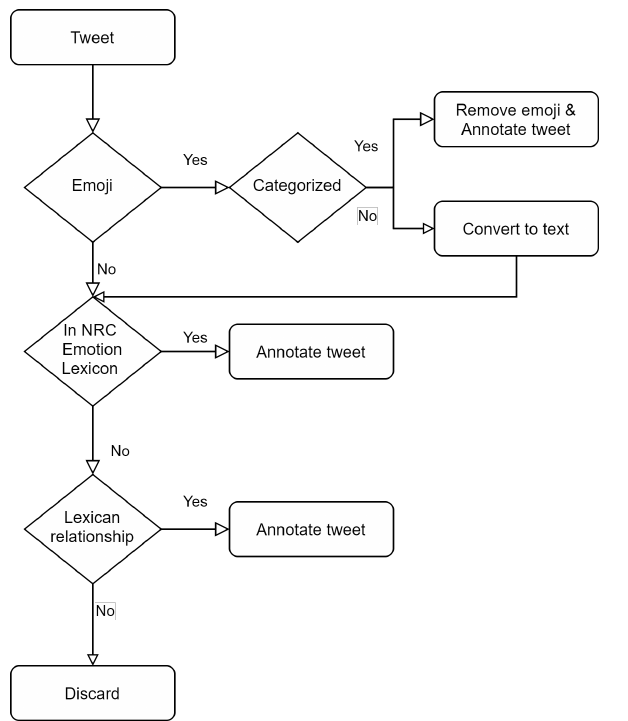
Figure 4. Rule based tweet annotation.